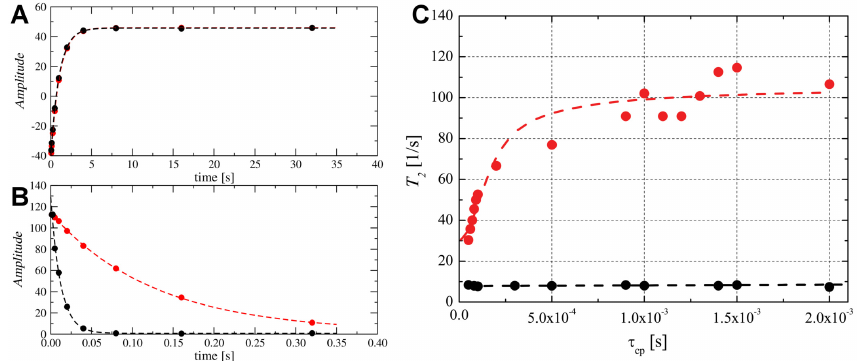
Figure 6. The 31 P relaxation experiments acquired for the phosphate group in the DPC micelle without (black) and with (red) TM4 segment. ( A ) 31 P longitudinal R 1 relaxation recovery and ( B ) transversal R 2 relaxation decay curves. ( C ) 31 P CPMG dispersion NMR experiment. The best fit obtained with CR model for DPC- d 38 micelle with TM4 segment is